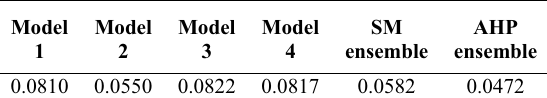
Table 8. RMSE of the KR models and ensembles in estimating parameters A x 3 , A x 4 and